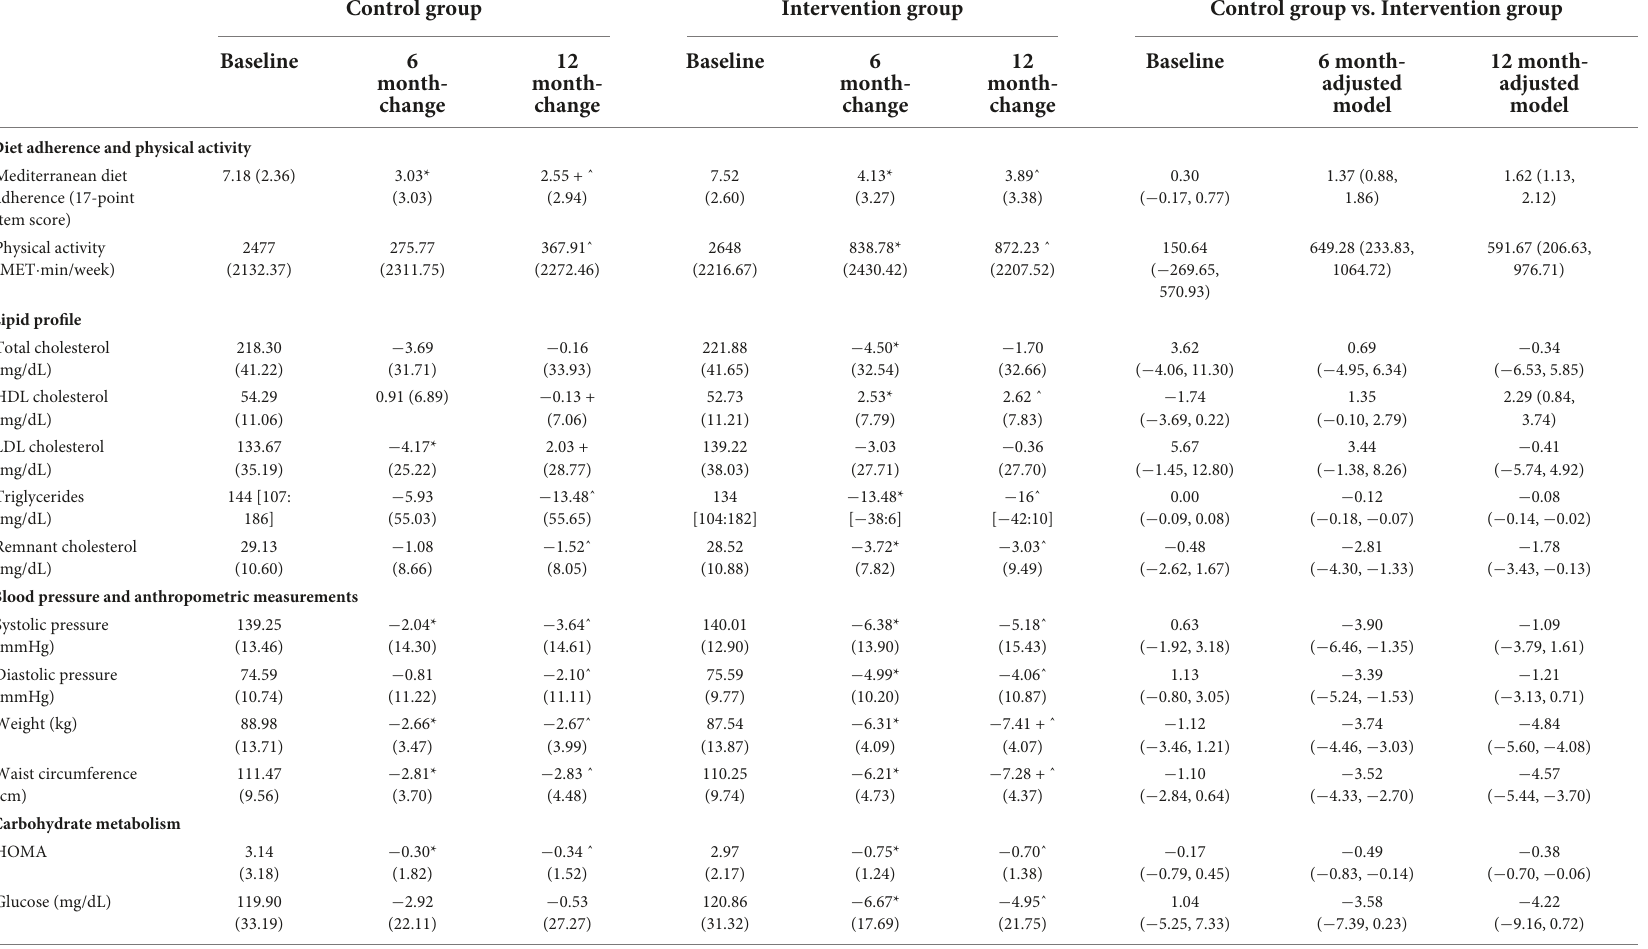
TABLE 1 Baseline and 6-and 12-month changes (mean and standard deviation) stratified in the control and intervention groups of the participants on the 17-item questionnaire, physical activity, biomarkers, and anthropometric measurements, lipid profile, carbohydrate metabolism, and hormones. Adjusted for sex and